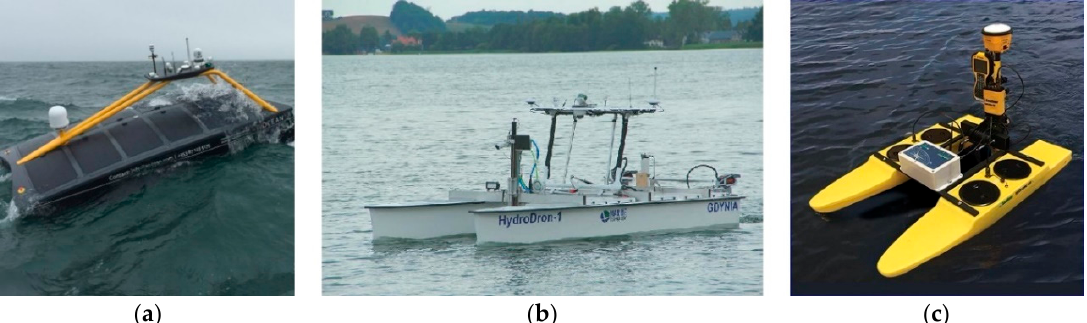
Figure 1. Hydrographic unmanned surface vessels. A multi-purpose XOCEAN XO-450 vessel ( a ), a double-hulled HydroDron ( b ), and a Seafloor Systems vessel ( c ).